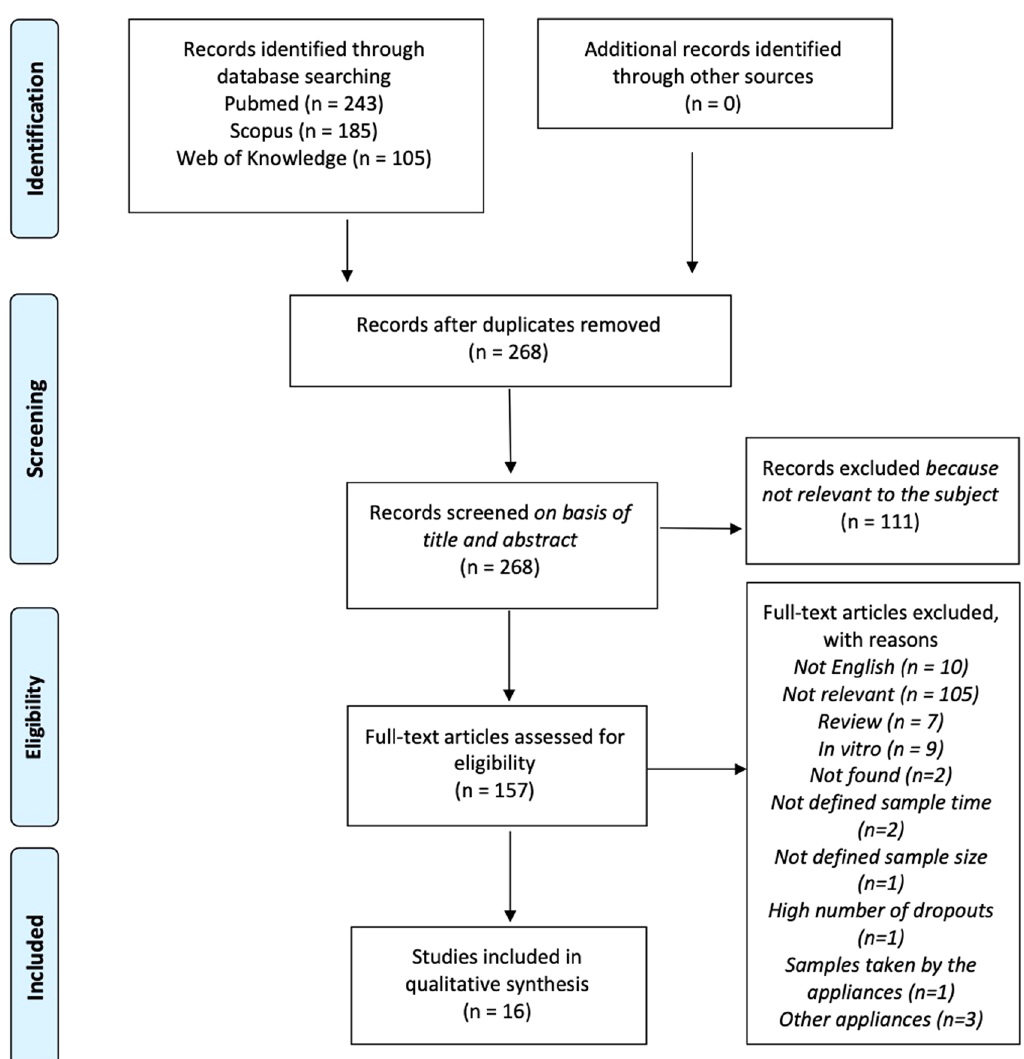
Figure 1. Flow diagram of the included studies according to the